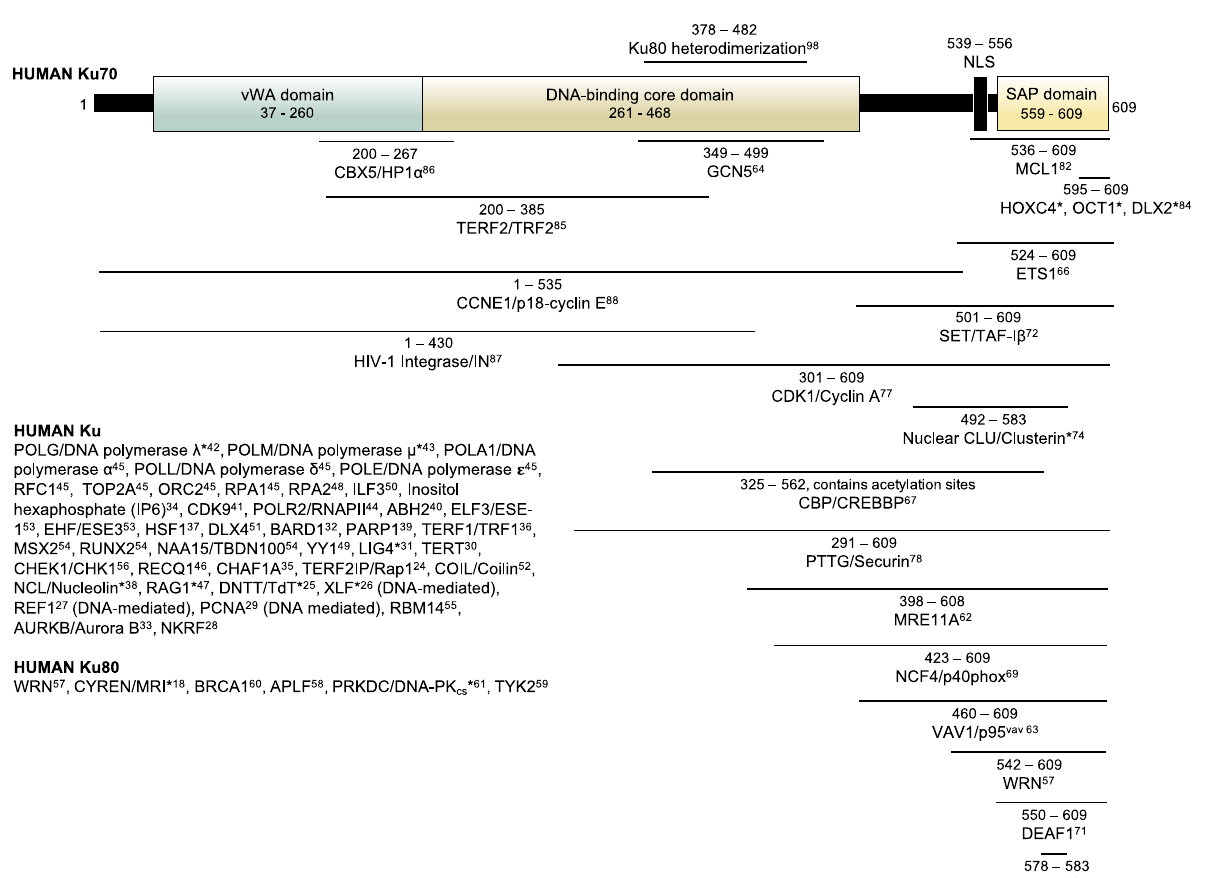
Figure 1. Schematic representation of Ku70 protein domains and mapped protein/molecule interactions. Interactions of the Ku80 subunit and Ku complex as a whole are listed. Note that interactions were determined using various cell lines and certain interactions may only occur under specific conditions. For example, TdT is only expressed in lymphocytes while VAV1/p95 vav is only expressed in hematopoietic cells. Proteins with an asterisk (*) only interact conditionally. Each cited interaction can be found in the References section through the indicated superscript number.